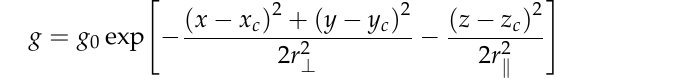
Figure 2. Schematic of DWDC method.